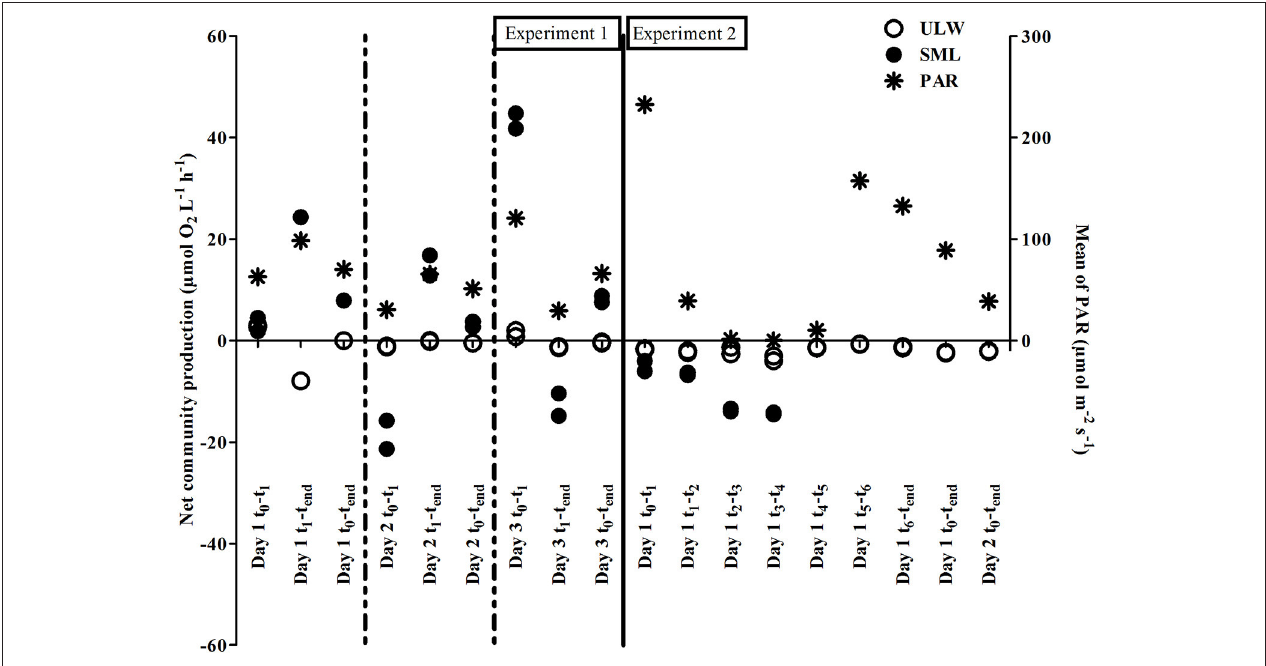
FIGURE 4 | Net community production (NCP) for the sea-surface microlayer (SML) and underlying water (ULW) and mean photosynthetically active radiation (PAR) for the two experiments.